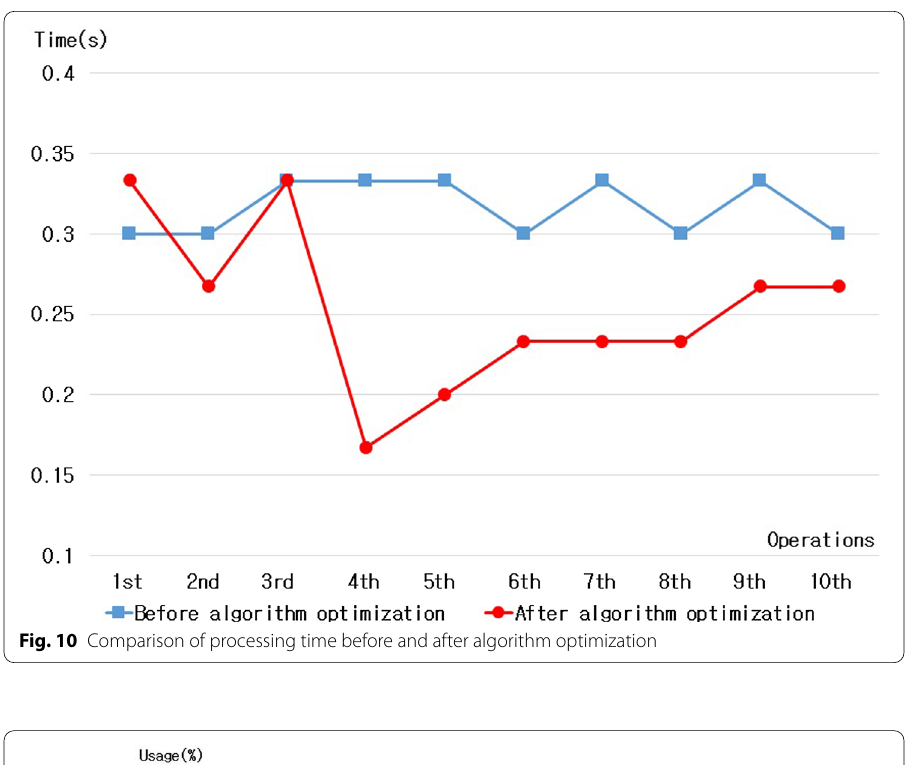
Fig. 10 Comparison of processing time before and after algorithm optimization